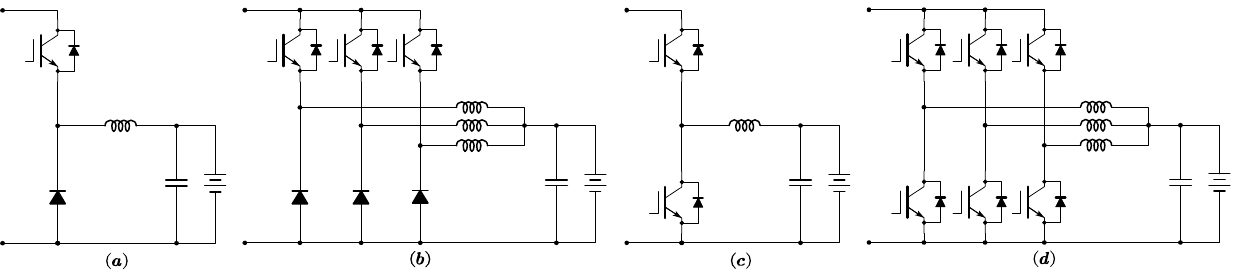
Figure 7. Non-isolated DC-DC converter topologies for electric vehicle ultra-fast charging application: ( a ) buck DC-DC converter; ( b ) three-phase interleaved DC-DC buck converter; ( c ) buck-boost DC-DC converter; ( d ) three-phase interleaved DC-DC buck-boost converter.